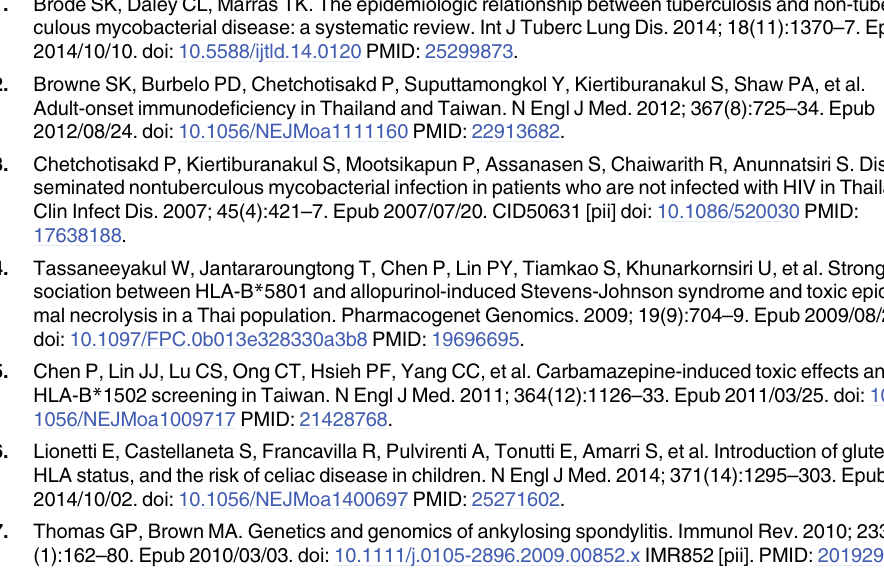
S4 Table. Allele frequencies of HLA-DQA1 and HLA-DQB1 among 32 cases and 30